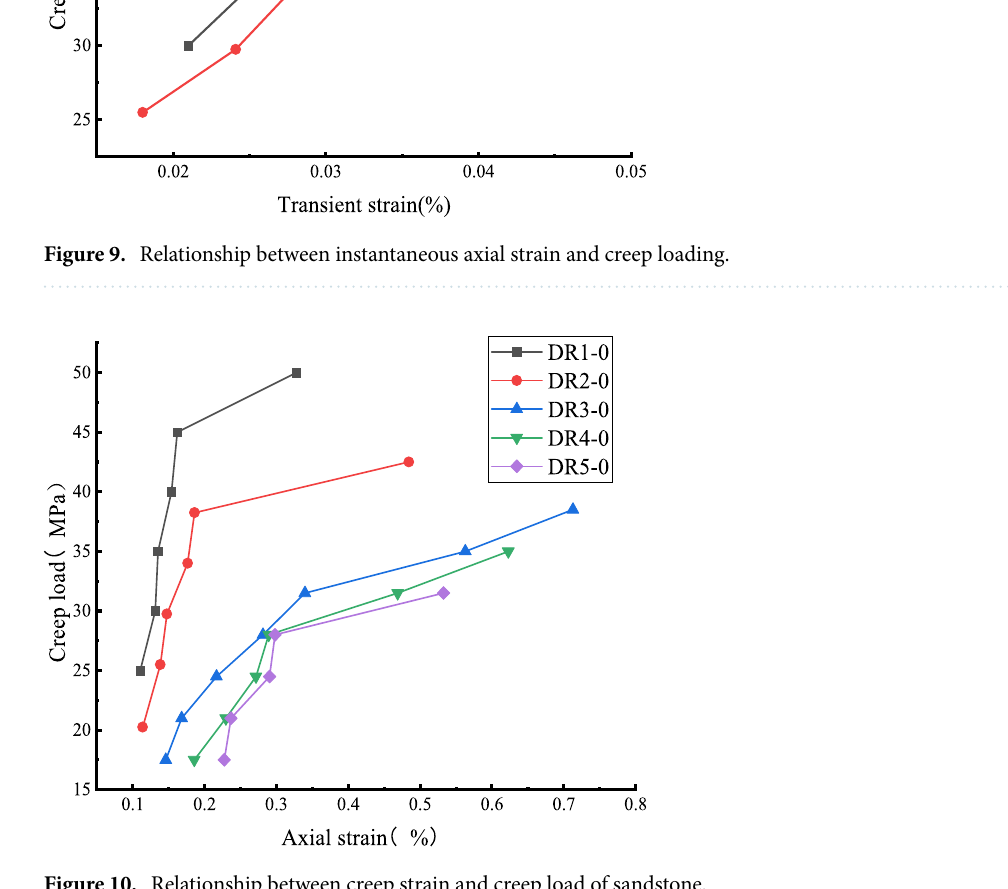
Figure 10. Relationship between creep strain and creep load of